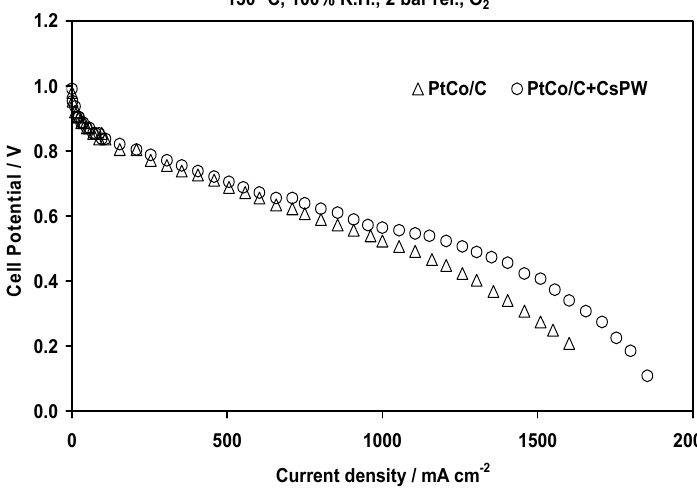
Figure 5. Comparison of the polarization curves for the promoter-based and the bare catalytic layers at 130 °C, 100% R.H., O 2 feed, 2 bar